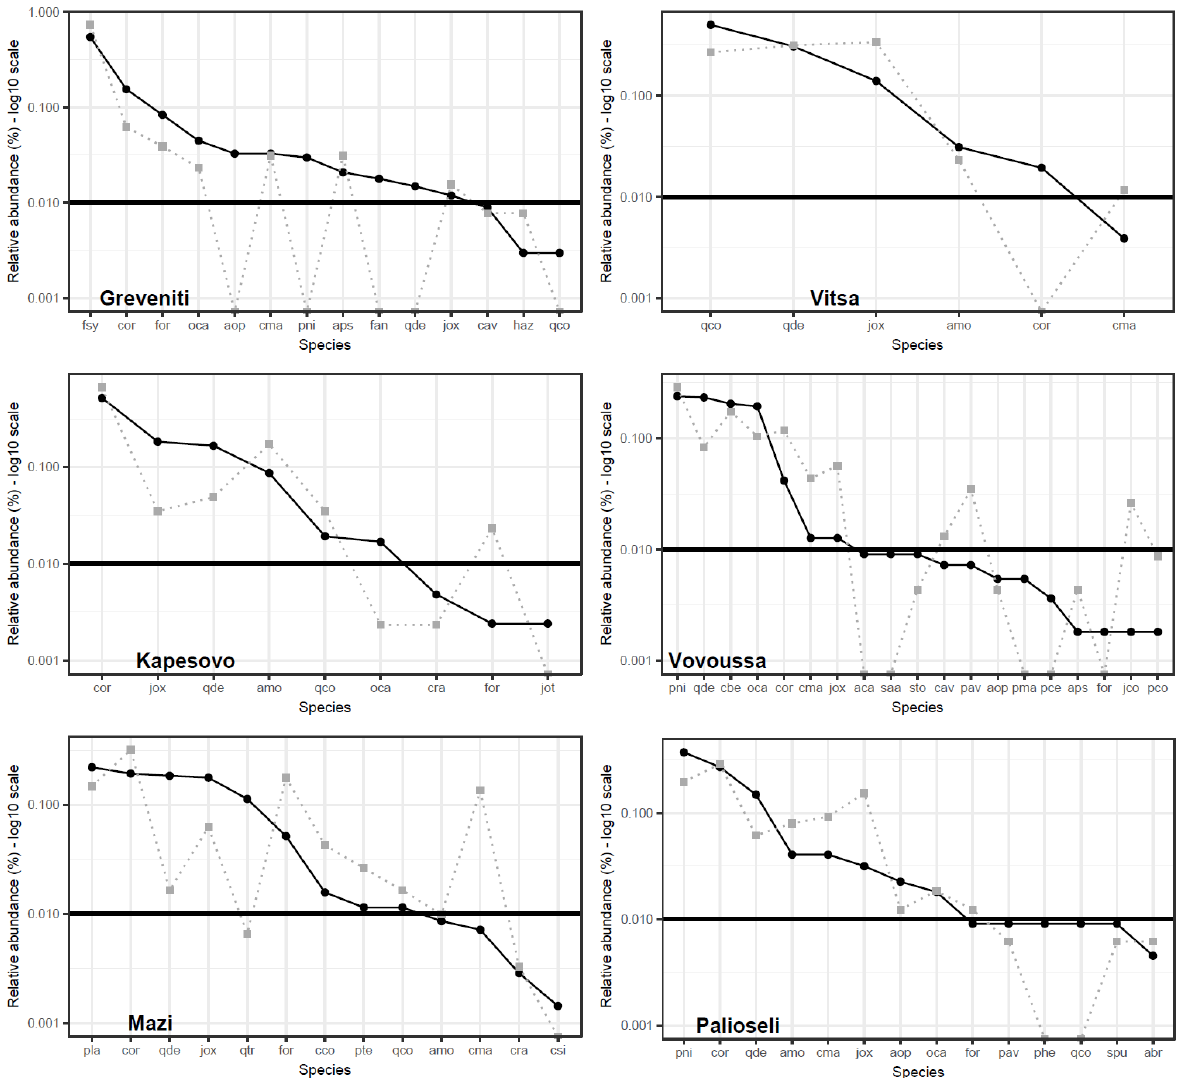
Figure 2. Tree species rank–abundance curves in the six sacred forests. Black curves indicate the relative abundance of the most common species in the canopy layer (main plots). Gray dotted curves indicate the relative abundance of saplings in the understory layer (subplots) matching the tree species found in the canopy. The horizontal straight line sets the abundance threshold of 1%. Full species names are given in Appendix I. Deciduous Quercus spp. ( Quercus cerris, Q. frainetto, Q. petraea , and Q. pubescens) are lumped into a single